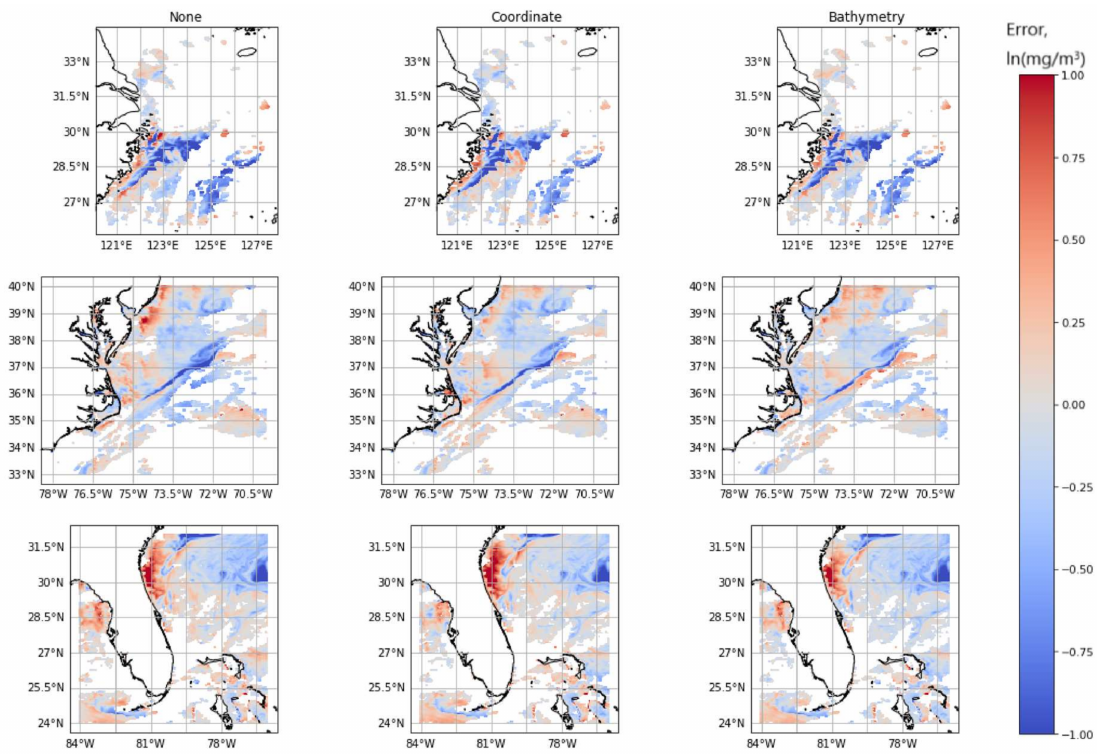
Figure 10. Error between ln ( Chl-a rec ) and ln ( Chl-a obs ) of the models in the 3